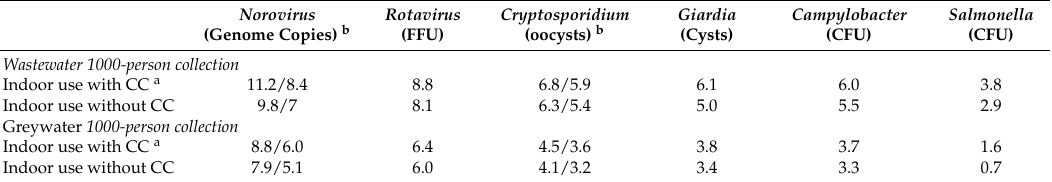
Table 1. Non-potable indoor use log 10 pathogen reductions targets for healthy adults given the 10 − 4 ppy (infection) benchmark for domestic wastewater and greywater assuming either the occurrence of a cross-connection event (CC) [2,9] or no event a . Norovirus Rotavirus Cryptosporidium Giardia Campylobacter Salmonella (Genome Copies) b (FFU) (oocysts) b (Cysts) (CFU) (CFU) Wastewater 1000-person collection Indoor use with CC